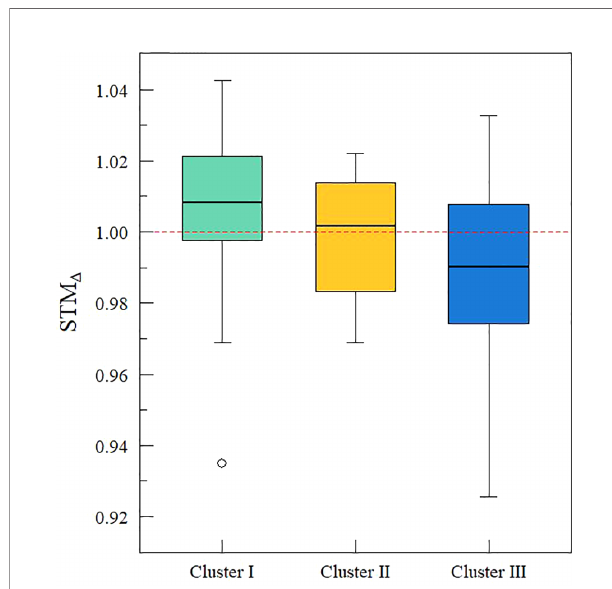
FIGURE 5 | Boxplot of short-term memory (STM) effect on leaf 13 C discrimination (STM Δ ) for each cluster. Red dashed line indicates the STM occurrence (STM D > 1). In each cluster ’ s boxplot, black line represents the median value. Boxplot contains the variation between 25 and 75% and gray circles are the outlier